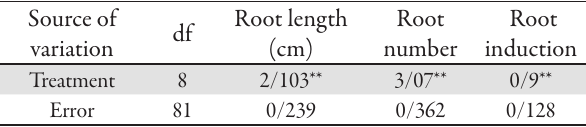
Tab. 5. Summary of treatment determined analysis of variance